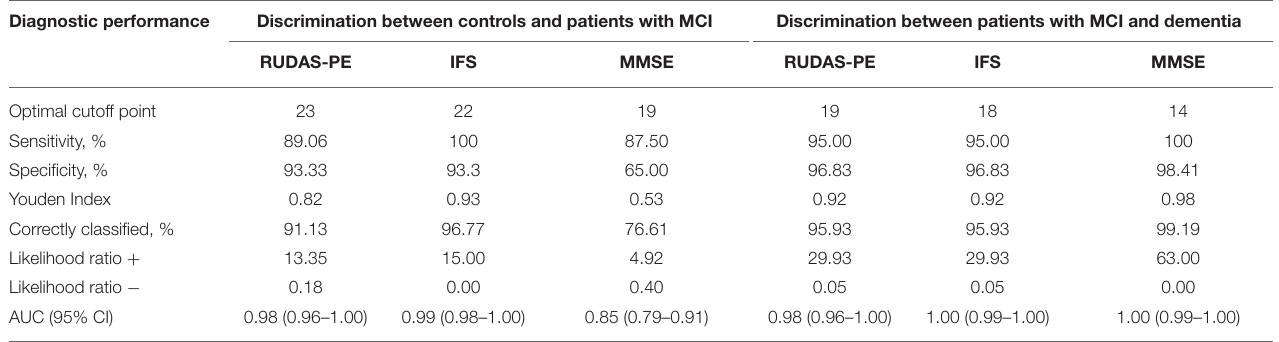
Diagnostic performance Discrimination between controls and patients with MCI Discrimination between patients with MCI and dementia